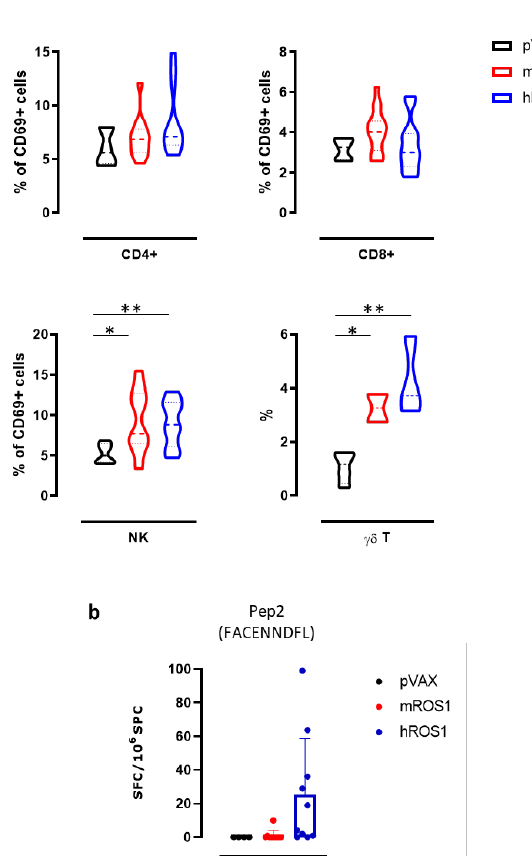
Figure 6. Anti-ROS1 cellular immune response induced by electrovaccination in wt mice. ( a ) Cytofluorimetric analysis of SPC collected from pVAX- (black), mROS1- (red), and hROS1- (blue) electrovaccinated wt mice (N = 6–12). CD45 + leukocytes were gated, and CD3 + CD4 + CD69 + cells were identified as activated CD4 + T cells, CD3 + CD8 + CD69 + were identified as activated CD8 + T cells, CD3 - CD49b + CD69 + were identified as activated NK cells, and CD3 + γδ + were identified as γδ T cells. Results are expressed as a percentage of positive cells using violin plots, which represent the mean and the 95% CI of each group of data. Statistically significant di ff erences in the percentages of γδ T cells and activated CD4 + and CD8 + T cells, and NK cells in ROS1-electrovacinated and control mice were analyzed using the Student’s t -test: * p = 0.02; ** p < 0.006. ( b ) The detection of the number of IFN- γ -producing cells when SPC that were collected from pVAX- (black; N = 4 mice), mROS1- (red; N = 10 mice), and hROS1- (blue; N = 10 mice) electrovaccinated wt mice were stimulated with the H2-D b immunodominant ROS1-derived peptide (Pep2, FACENNDFL). Results are expressed as spot-forming cells (SFC) per million of SPC plated ± SD and were analyzed using the Student’s t -test. 3.5. Anti-ROS1 DNA Vaccination Impairs the Development of Spontaneous Lung Cancers in K-Ras G12D Transgenic Mice.